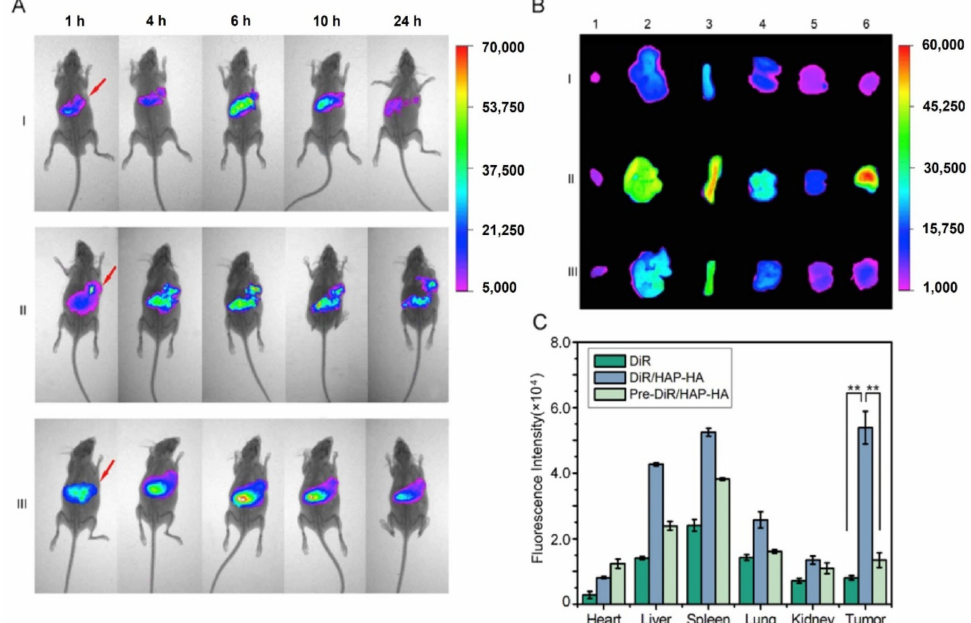
Figure 10. In vivo effects of DOX/HAp-HA NPs. In order to evaluate the tumor targeting capability of the NPs, they were labelled with the lipophilic and near-infrared fluorescent cyanine dye DiR. ( A ) Fluorescence images of the in vivo experiments carried out on Hep tumor-bearing mice at different time points after the injection of ( I ) free DiR, ( II ) DiR/HAp-HA NPs and ( III ) DiR/HAp-HA NPs with pre-injection of free HA. ( B ) Ex vivo fluorescence imaging of normal and tumor tissues obtained from euthanized Hep cells xenografts bearing mice after 24 h of injection. The numbers are assigned to the heart, the liver, the spleen, the lung, the kidney and the tumor, in corresponding ascendant order. ( C ) Fluorescence intensity analysis ( n = 3 ) and p < 0.01. Republished from [9] with permission of Elsevier. Copyright ©